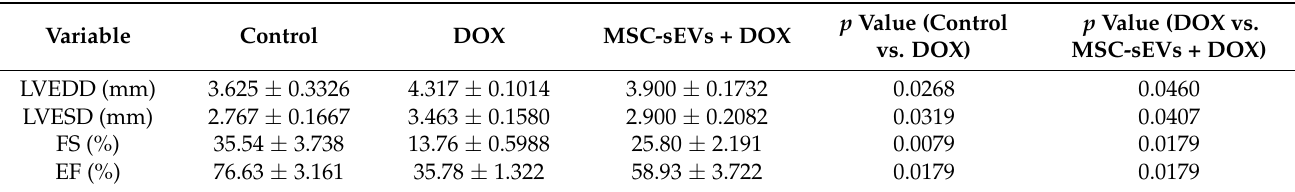
Table 1. MSC-sEVs improve both dilated cardiomyopathy and cardiac functions induced by DOX in an in vivo mouse model. Echocardiography was performed in the control, DOX, and MSC-sEVs + DOX groups 14 days after DOX injection. Quantitative echocardiographic group data: LVEDD (mm), LVESD (mm), FS (%) and EF (%) ( n = 8/group). Values are mean ± SEM. Each p -value is the result of a comparison between two groups (control vs. DOX, DOX vs. MSC-sEVs + DOX).